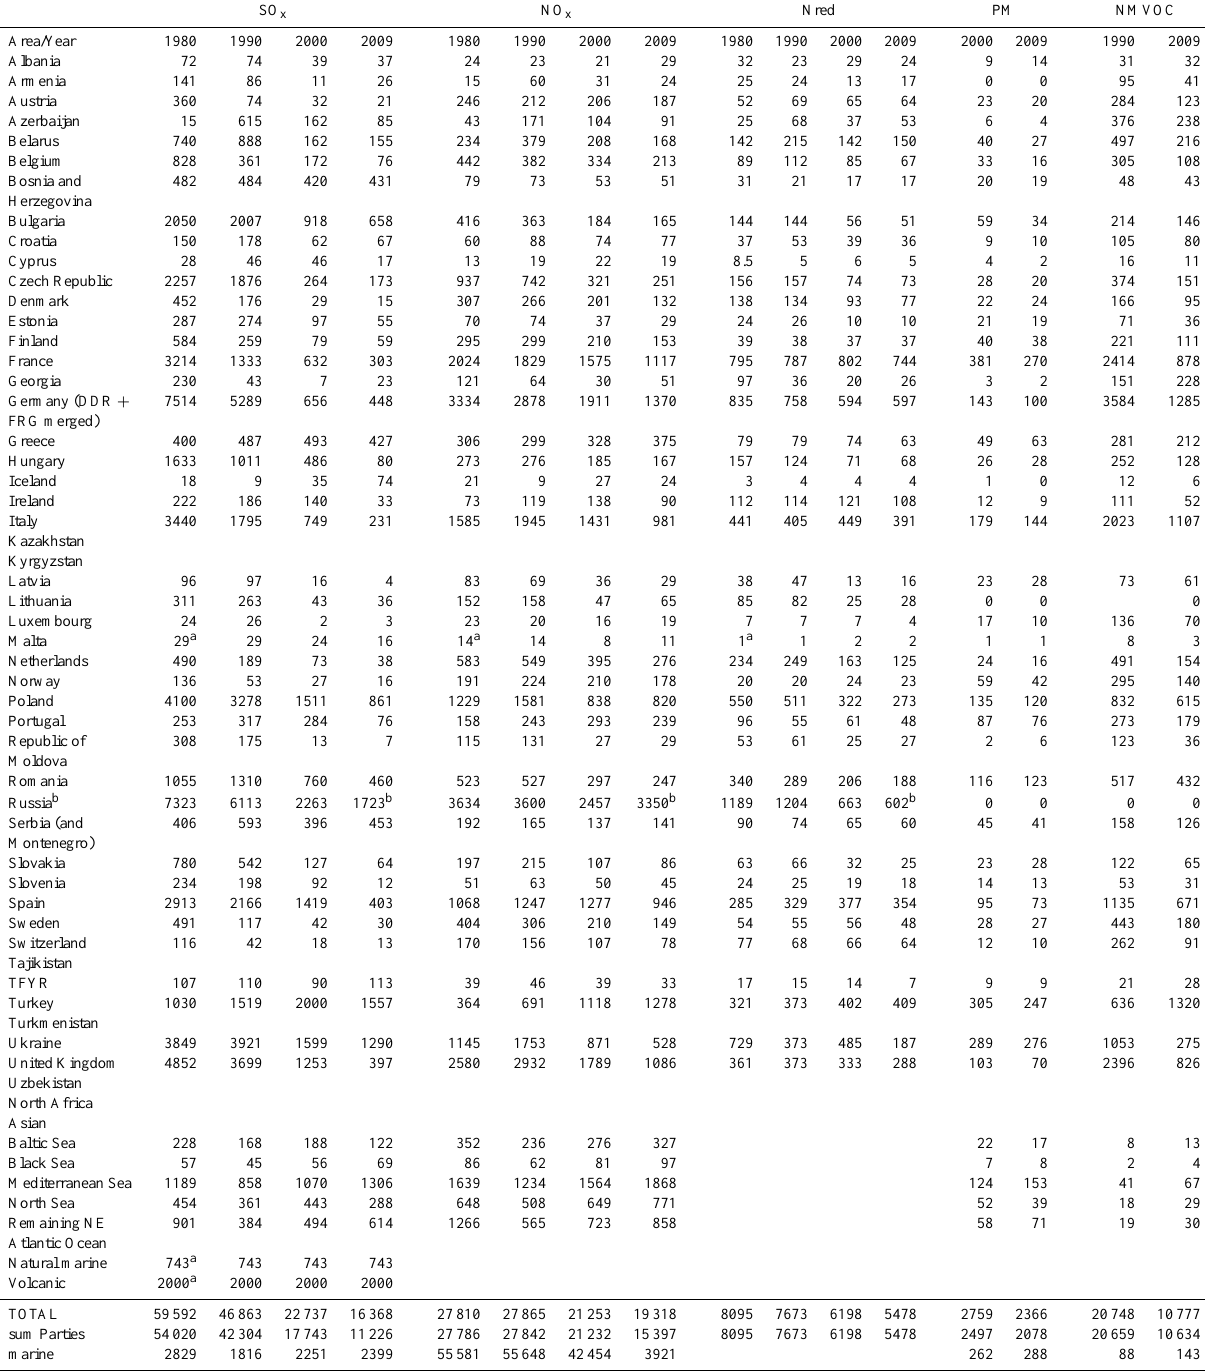
Table B1. Emission data used for trend analysis (from EMEP/CEIP,